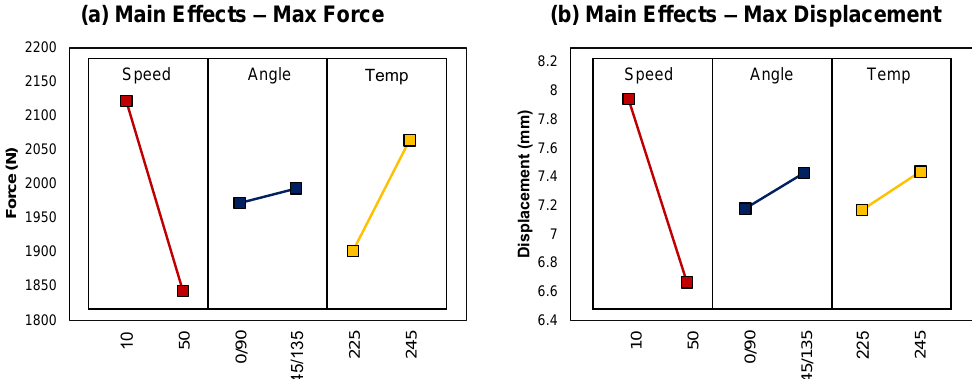
Figure 13. Main effects plots for ( a ) force at failure and ( b ) deflection at